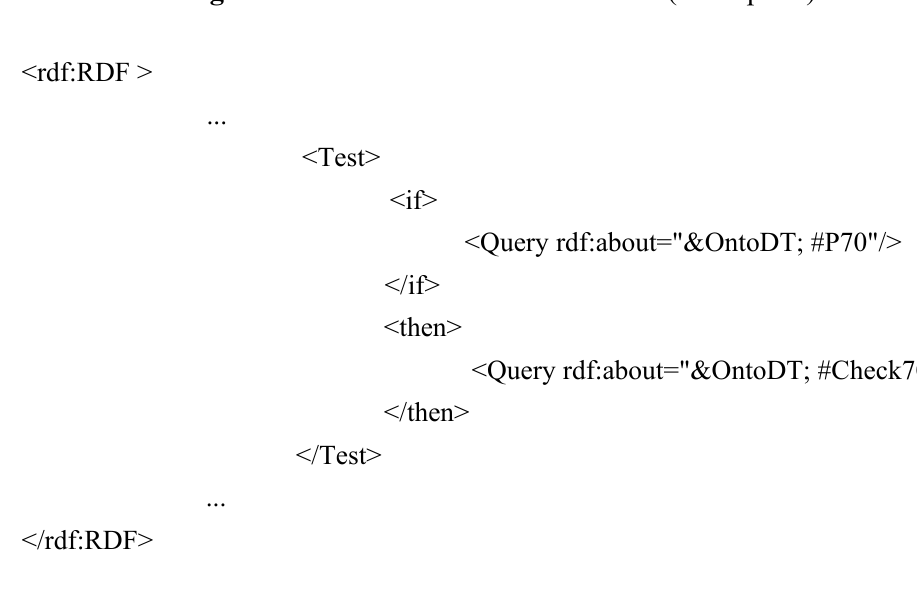
Figure 8. RDF annotation of the SBVR (Example